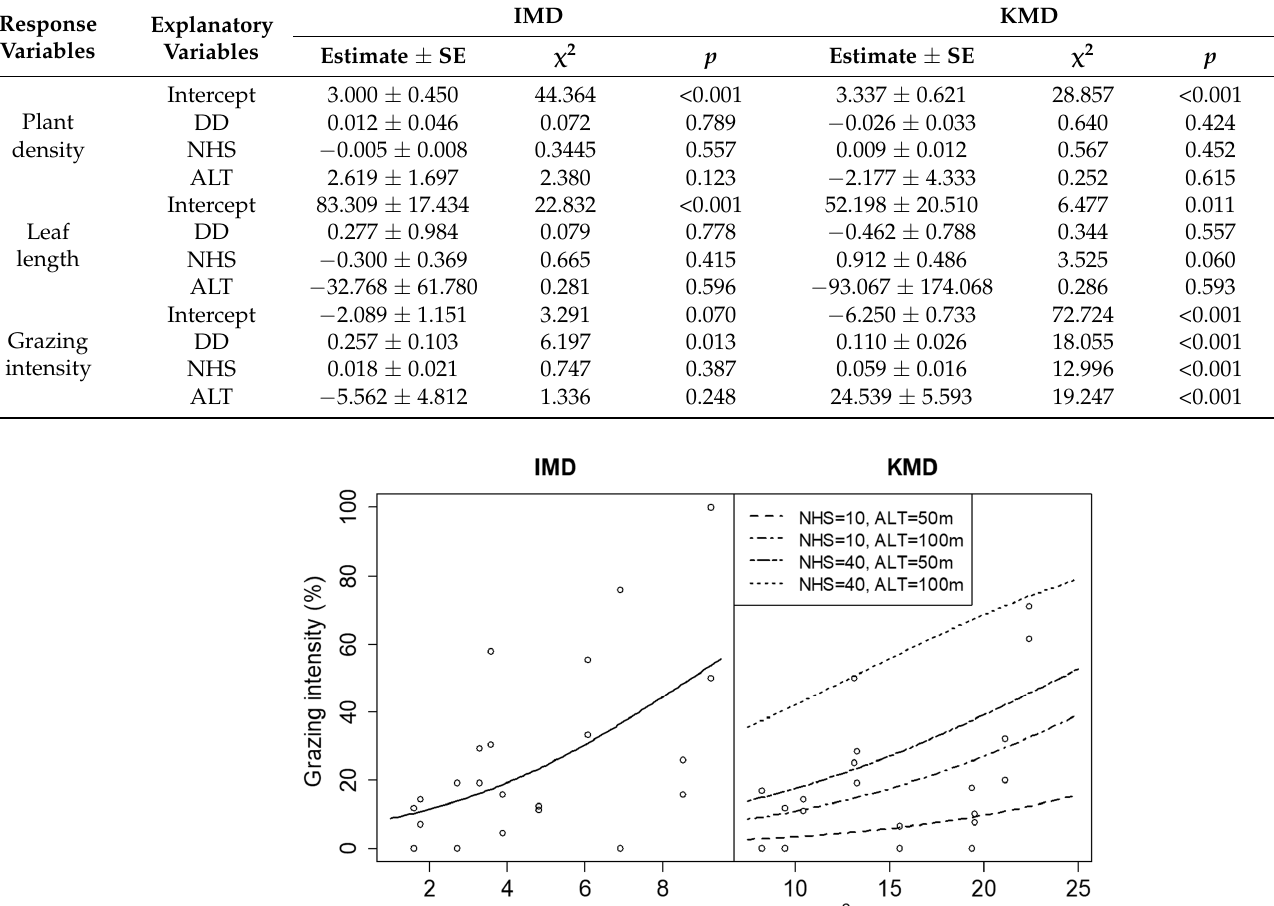
Table 2. Parameter estimate ( ± standard error) for the generalized linear mixed models (GLMMs) for plant density, leaf length, and grazing intensity of Dryopteris crassirhizoma in Iburi management district (IMD) and Kushiro management district (KMD) in 2014. The explanatory variables included deer density (DD), the number of herbaceous species (NHS), and altitude (ALT).